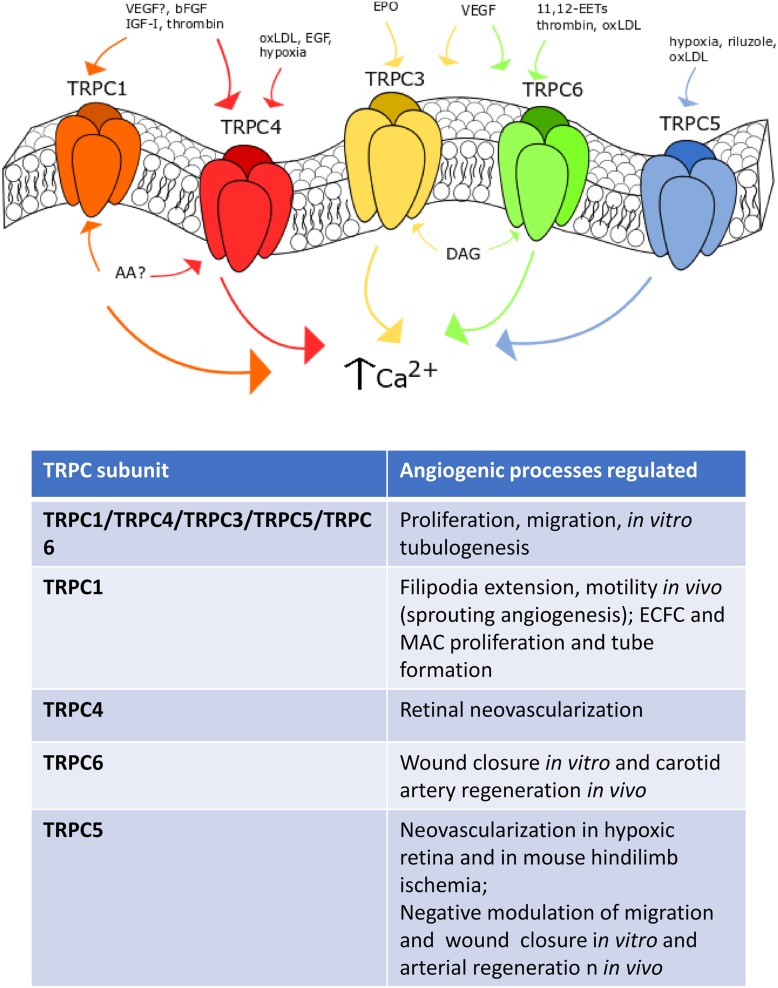
TRPC channels in angiogenesis. Representation of the main TRPC channels involved in angiogenesis. TRPC1 mediates angiogenesis after VEGF- (still debated), IGF-, bFGF- and thrombin-induced stimulation. TRPC4 is sensitive to EGF, oxLDL and hypoxia. TRPC3 responds to erythropoietin (EPO) and VEGF stimulation, such as TRPC6, which can be also activated by oxLDL, thrombin and 14,15-EETs. Finally, TRPC5 is sensitive to hypoxia, riluzole and oxLDL-dependent activation.